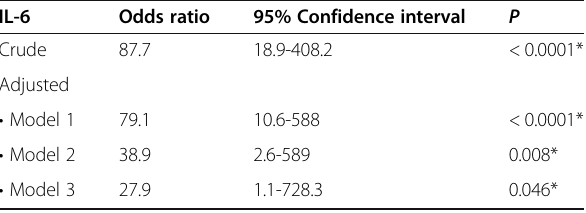
Table 3 IL-6 as a predictor of COVID-19